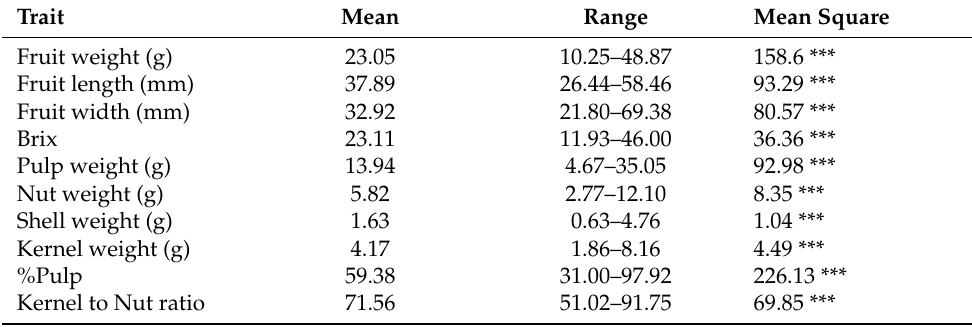
Table 2. Trait variation and mean squares.